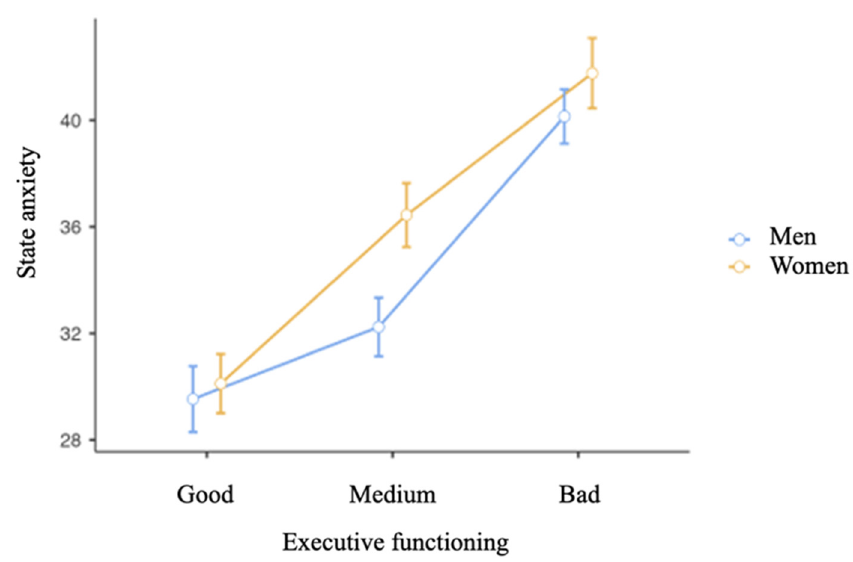
Figure 5. Means of state anxiety between the sexes of the participants in each level of executive functioning. Table 3. A t-test analysis . Differences in state anxiety between sexes, according to the level of executive functioning.